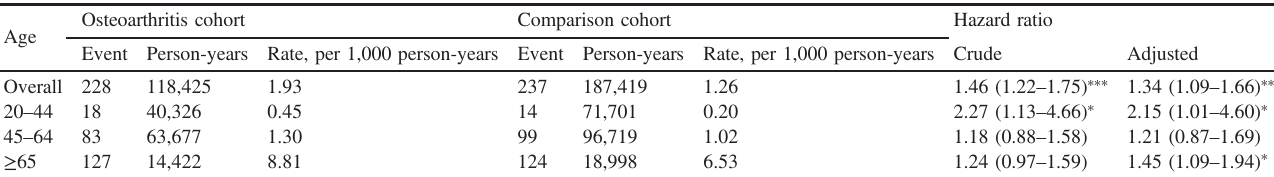
Table 2. Incidence of ischemic stroke and osteoarthritis cohort to comparison cohort hazard ratio (95% con fi dence interval) by age Osteoarthritis cohort Comparison cohort Age